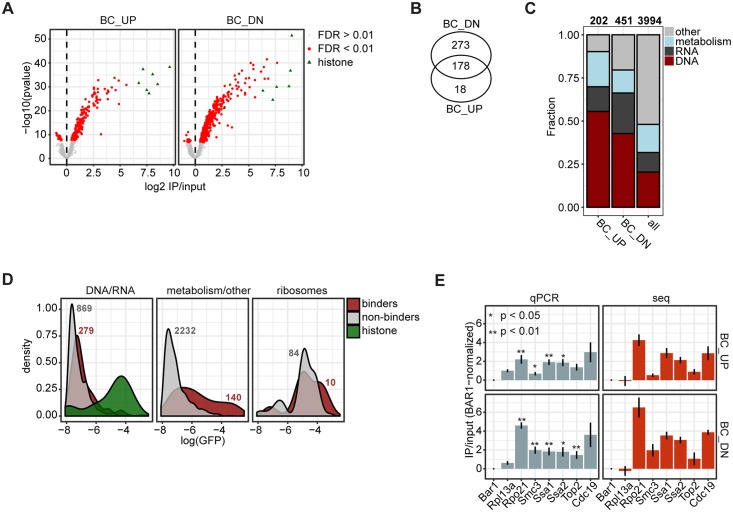
Identifying chromatin binders with DNA barcode counting.(A) Volcano plots showing the average log2 ChIP/input versus significance (p-value) calculated for 3,994 factors for BC_UP and 3,995 factors for BC_DN across 6 independent biological experiments. The red colour indicates factors with a Benjamini-Hochberg–adjusted p-value < 0.01. Green triangles represent the barcodes associated with the TAP-tagged histone proteins in the library. (B) Venn diagram indicating the number of factors that are significant (FC > 0; FDR < 0.01) at BC_UP, BC_DN, or both. (C) Bar plot showing the fraction of factors in 4 different categories that were determined by using GO annotations (see Methods). The first 2 bars show the fractions in the group of binders (at either BC_UP or BC_DN). The right bar shows the fraction in the background set (the entire library). (D) Density plot of GFP abundance using data from the Cyclops database (http://cyclops.ccbr.utoronto.ca/). The binders were defined as before (FC > 0; FDR < 0.01), and the categories are similar to those in panel C. The ribosome category was defined based on the CYC2008 database (http://wodaklab.org/cyc2008/). Histones are shown separately; they bind at the DNA and are highly abundant. The numbers indicate the size of each group. (E) ChIP-qPCR of selected TAP-tagged strains from the barcoded KanMX Epi-Decoder library, with specific primers in proximity to BC_UP and BC_DN. To compare the barcode counts with ChIP-qPCR signal, the samples were normalized to the Bar1-TAP signal (Bar1 is not expressed in these cells) before calculating ChIP/input. The average of 3 biological replicates is shown; the error bars indicate the SD. Rpl31A—a highly expressed ribosomal subunit frequently used in anchor away studies to deplete proteins from the nucleus—was used as a negative control and as a reference to determine binding specificity in the qPCR analysis. Rpo21 is the largest subunit of RNA polymerase II, Smc3 is a cohesin subunit, Ssa1 and Ssa2 are HSP70 chaperones, Top2 is topoisomerase II, and Cdc19/Pyk1 is pyruvate kinase. The p-values from a two-sided t test compared to Rpl13A are indicated by asterisks. Underlying data for Fig 2C and Fig 2E in S1 Data. BC_DN, downstream barcode; BC_UP, upstream barcode; ChIP, chromatin immunoprecipitation; FC, fold change; FDR, false discovery rate; GFP, green fluorescent protein; GO, gene ontology; IP, immunoprecipitation; qPCR, quantitative PCR; TAP, Tandem Affinity Purification.